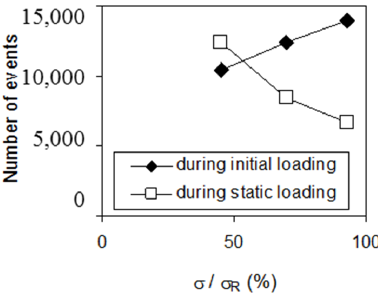
Figure 7. Number of AE events recorded during initial loading up to the nominal load and during the static loading at a constant load.